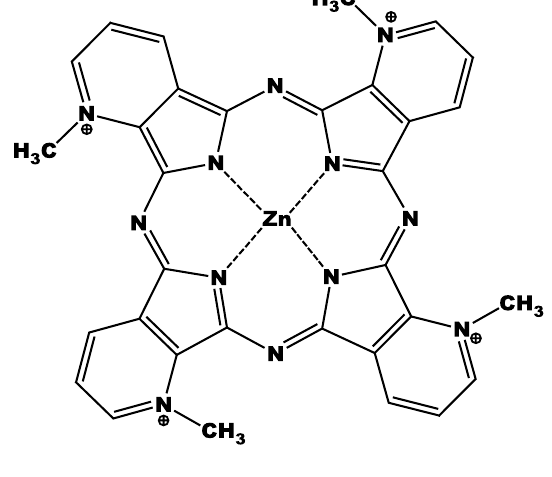
Scheme 1. Chemical structure of